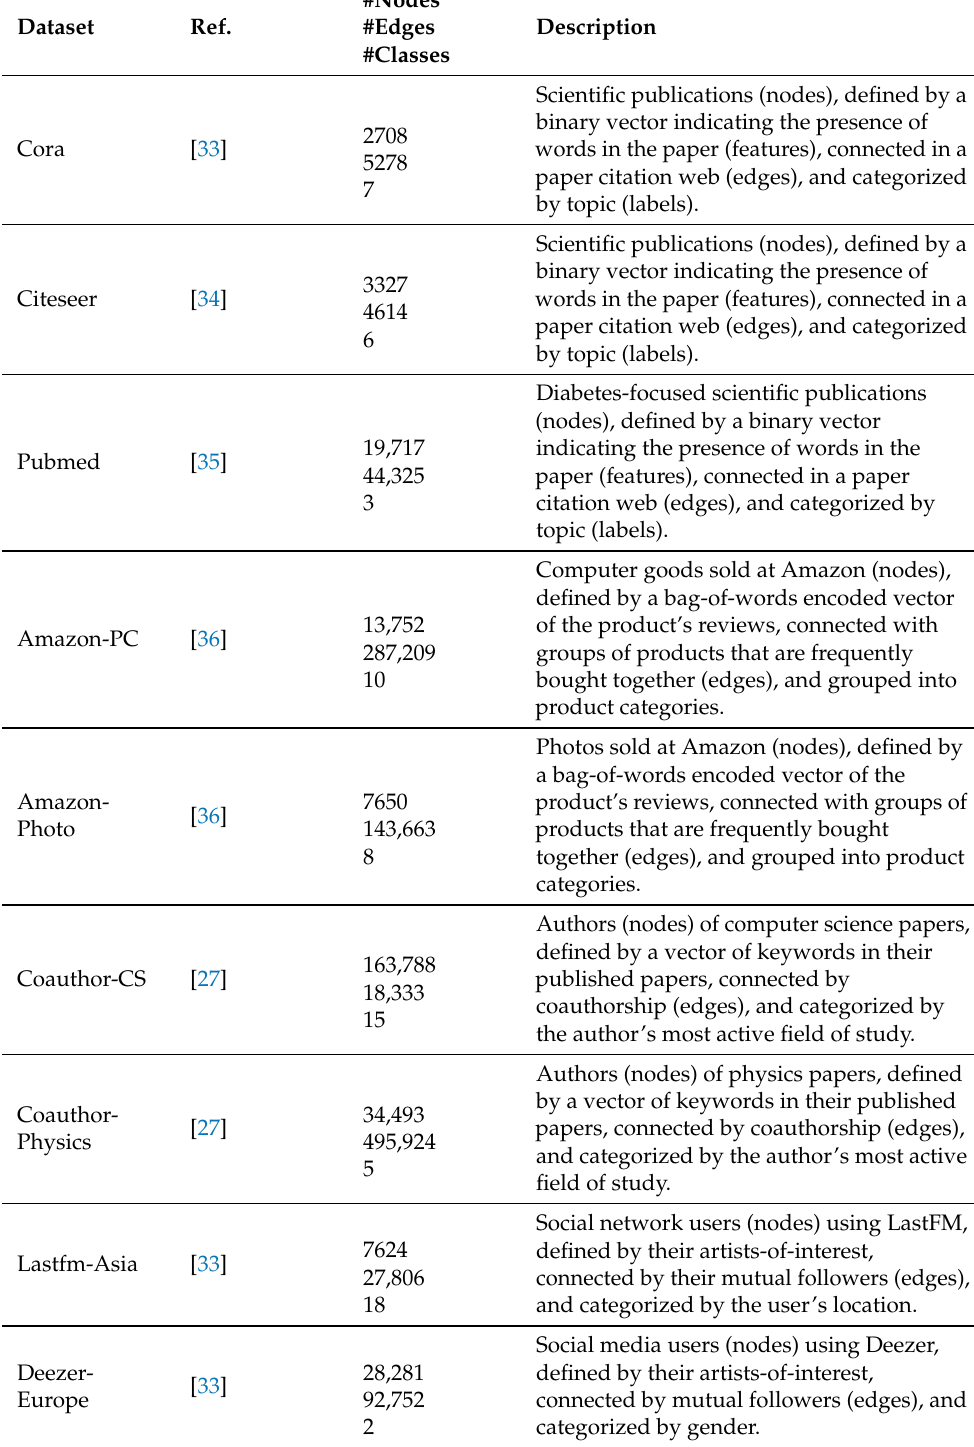
Table 1. Dataset information, like network structure and domain-specific